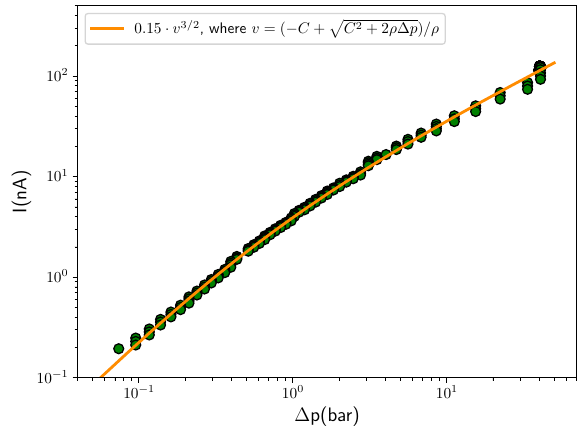
Figure 5. Example of the streaming current I s against the pressure drop (cid:31) p . Following Eq. (12) the streaming v 3 / 2 , solving Eq. (1) for v allows one to express I s in terms of (cid:31) p . The orange line shows current scales as I s ∼ that this gives an excellent prediction of the experimental results, for a certain value of C , which is determined by the filter’s porosity and the liquid viscosity. This causes C to differ slightly between experiments.